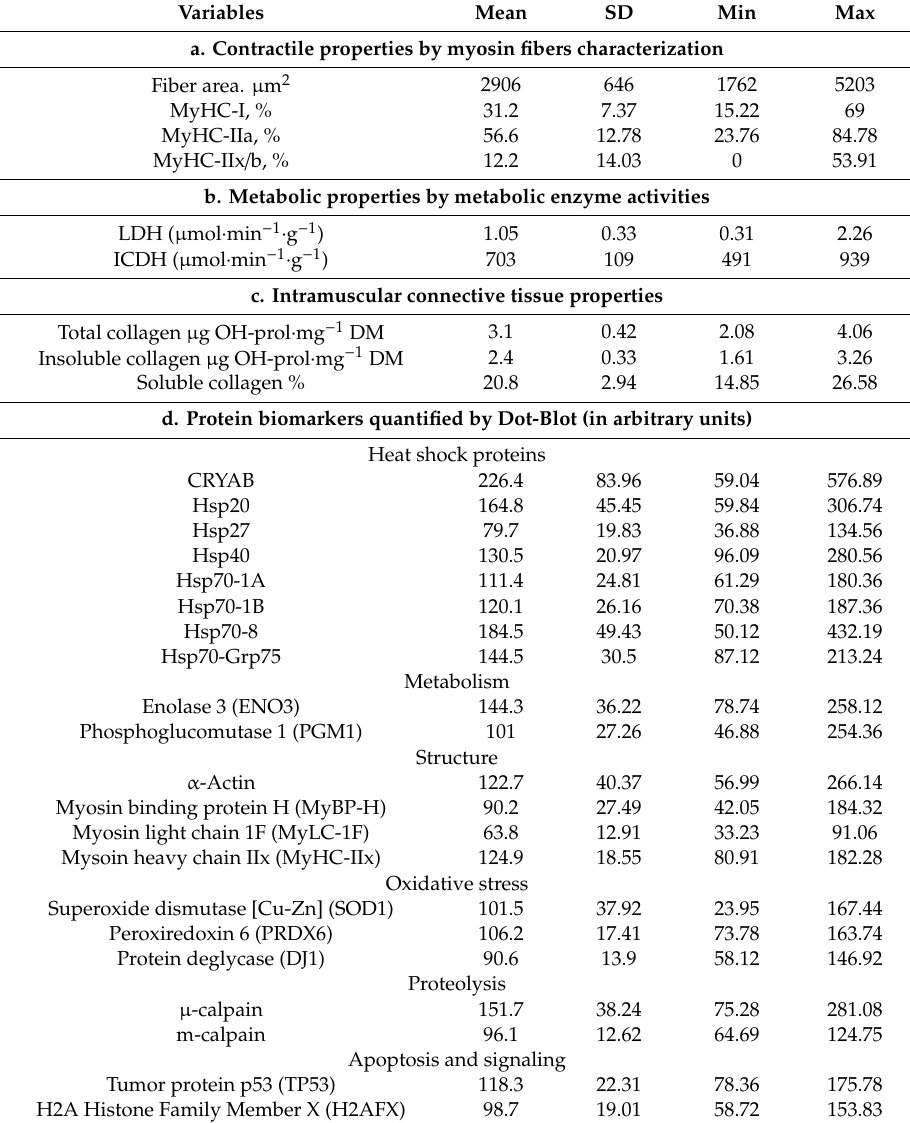
Table 3. Average values and variations of the data from the muscle level describing the 30 quantified characteristics in Longissimus thoracis muscle including protein biomarkers for the 110